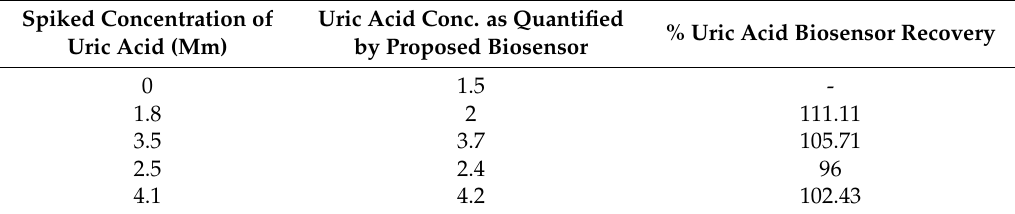
Table 2. The recovery method results for the analytical reliability of uric acid biosensor. Spiked Concentration of Uric Acid Conc. as Quantified Uric Acid (Mm) by Proposed Biosensor